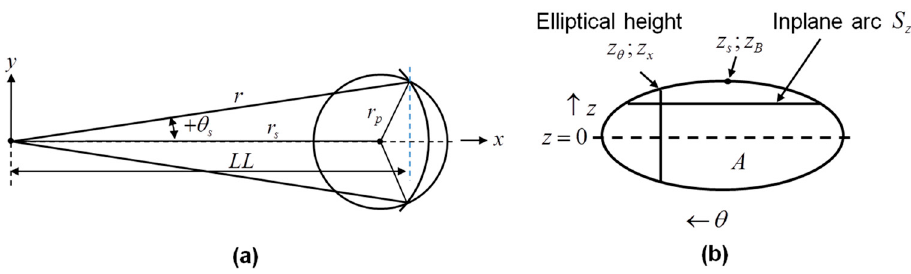
Figure 1. Cylindrical plane cutting through sphere ( a ) top view of plane at z = 0, ( b ) side view. The cylindrical plane cuts through the sphere when: